Question: From the figure, is the trend upward or downward?
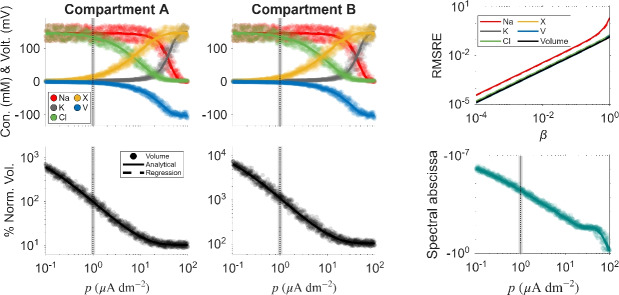
Answer: increasing